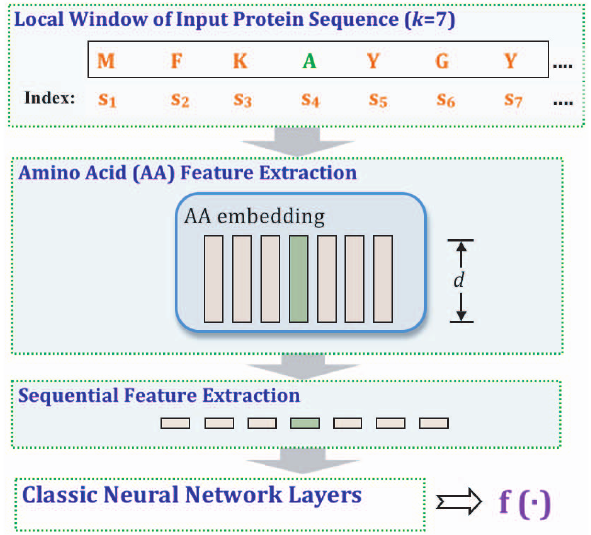
Figure 3. Network architecture for training the ‘‘natural protein’’ auxiliary task. The ‘‘natural protein’’ auxiliary task aiming to model the local patterns of amino acids that naturally occur in protein sequences. Using local windows in the unlabeled protein sequences as positive examples and randomly modified windows as negative examples, the network learns the feature representations for each amino acid. In contrast to the network illustrated in Figure 1, the network contains only the amino acid embedding module in the first layer of the network. The learned embedding is encoded into the real valued parameter matrix of the amino acid feature extraction layer.